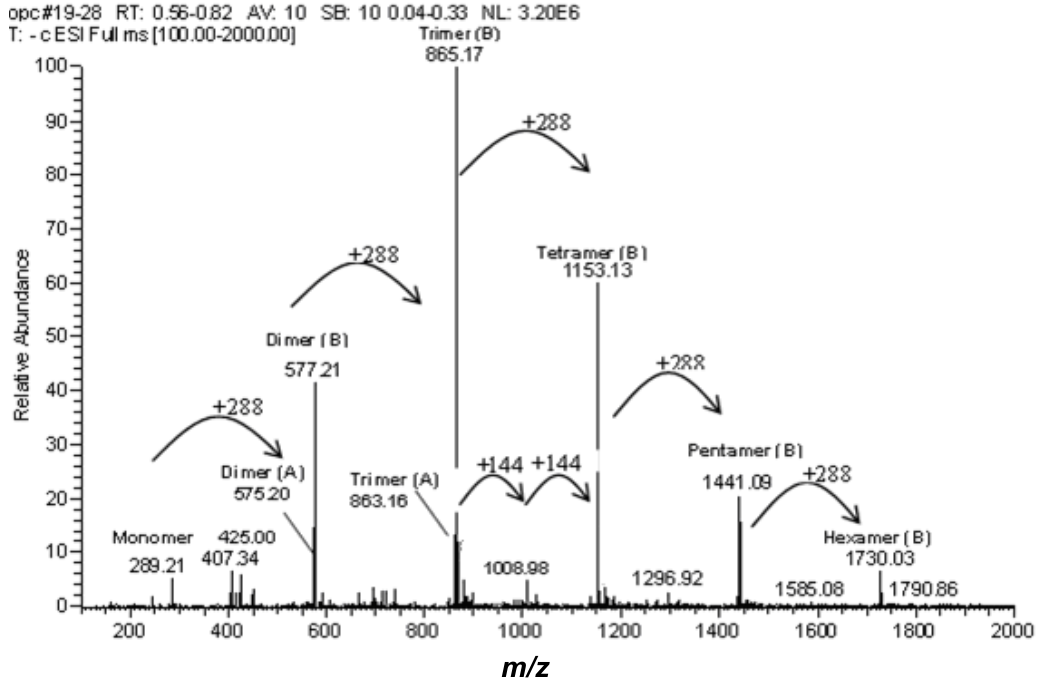
Figure 4. ESI-MS spectrum of purified OPCs collected under anionic mode. A series of peaks were detected with m/z differing 288 starting from monomer (289) and ending at hexamer (1,730). A type dimer and trimer were also detected as small peaks at m/z 575 and 863. A doubly charged haptomer was also found at